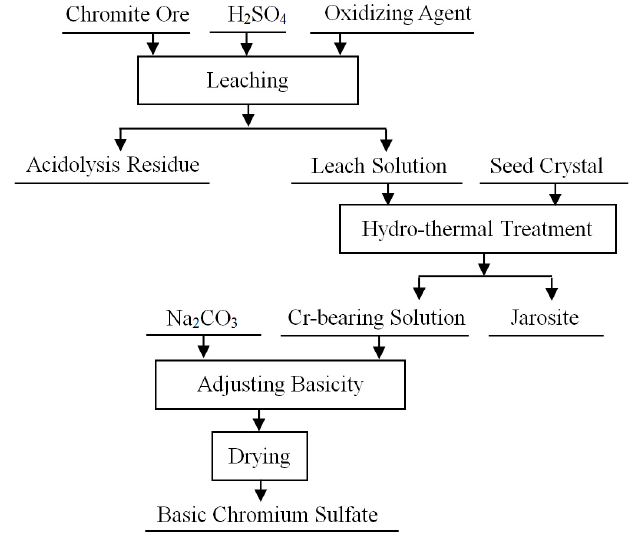
Figure 4. Process flow chart for the production of a chromium salt from chromite ore.